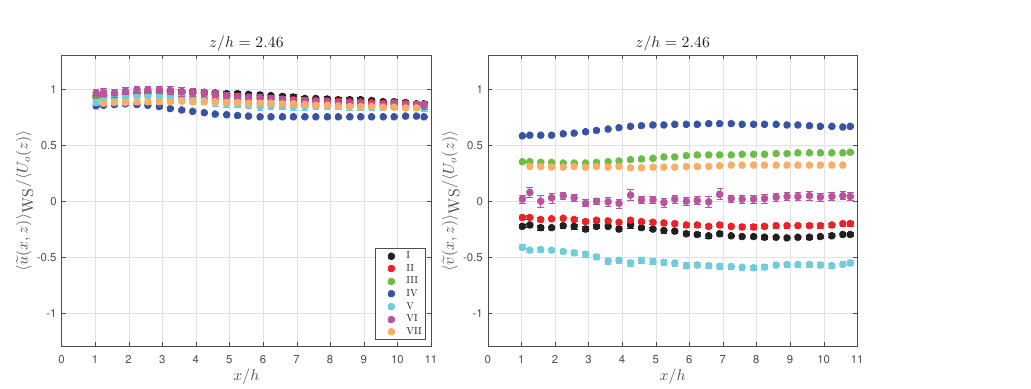
Figure 11. Same as Fig. 9 but for z/h =